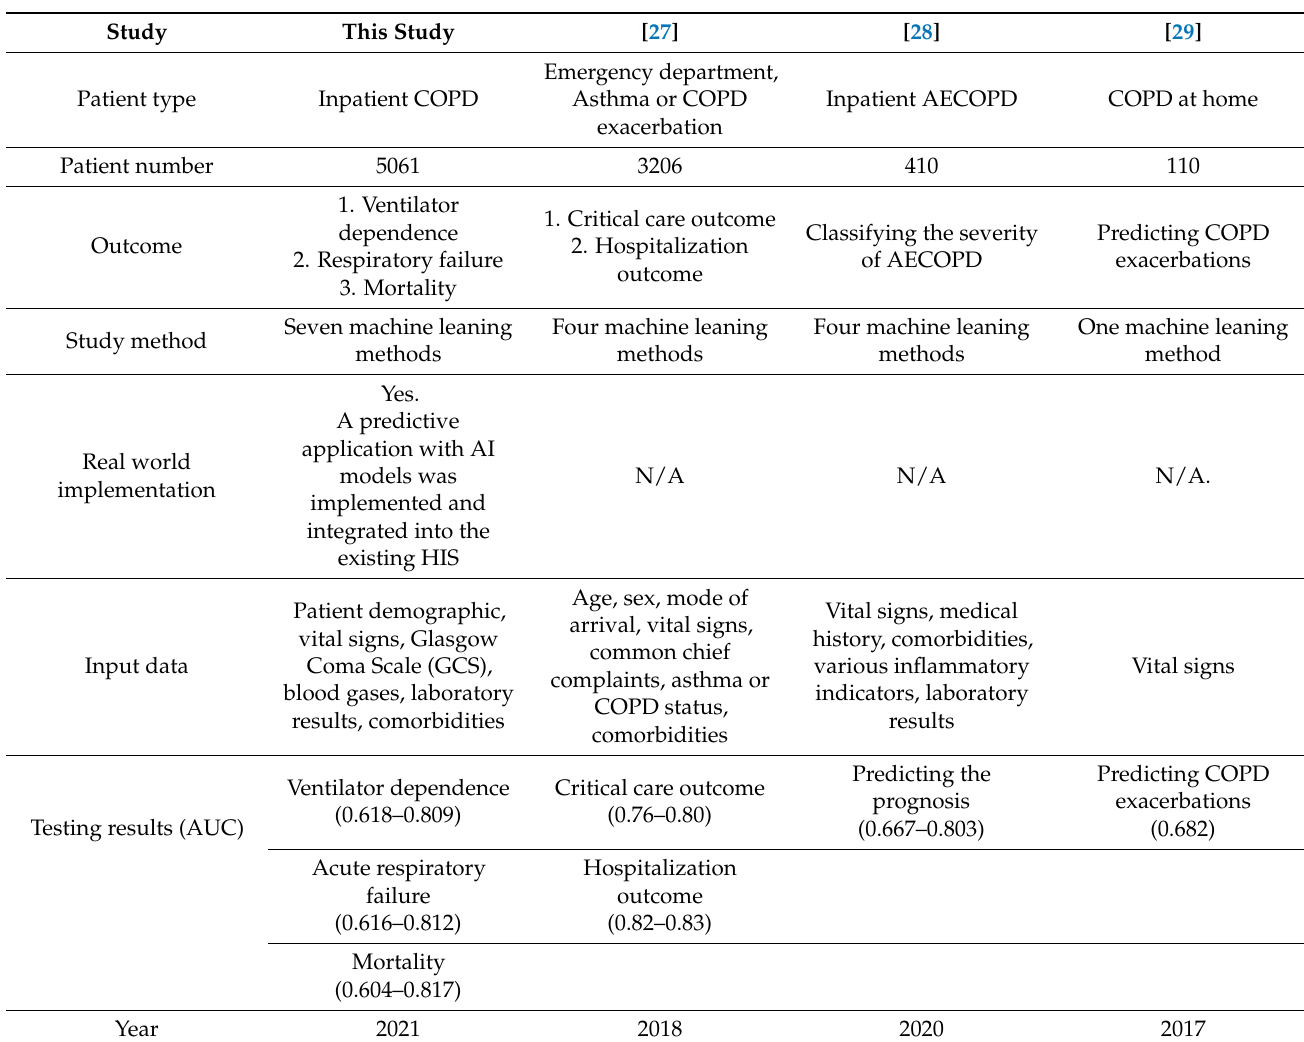
Table 5. A comparison with related